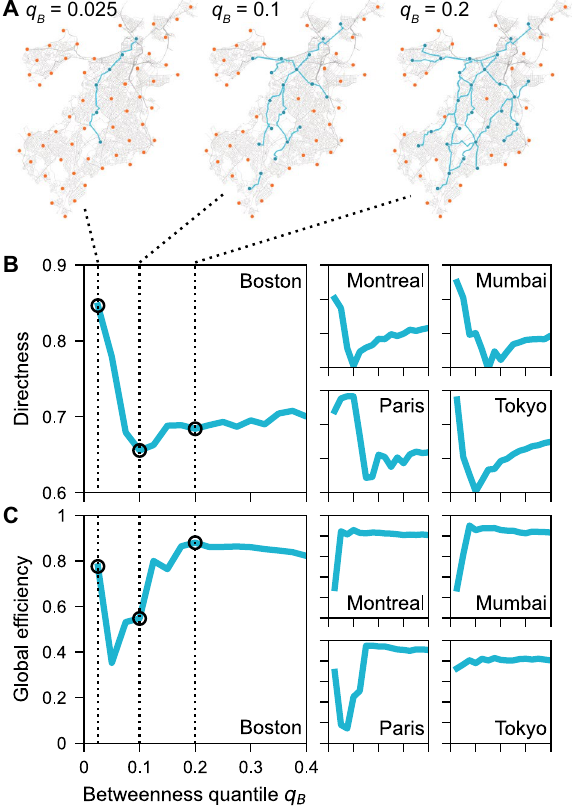
Figure 5. Network consolidation: Bicycle network growth has a dip of decreasing directness. ( A ) Three early stages of betweenness growth in Boston. ( B ) Directness sharply decreases initially due to tree-like growth (compare q B = 0.025 and q B = 0.1 for Boston). Once directness has reached a minimum ( q B = 0.1 ), it starts growing slowly due to the appearance of cycles ( q B = 0.2 ). The process is similar for the other cities (shown here for Montreal, Mumbai, Paris, Tokyo) and also holds for random growth, see Supplementary Figs. 5, 7, 8, 10. ( C ) We find mixed results for global efficiency: Mumbai and Montreal display a single jump, Tokyo is flat, while Boston and Paris shown an initial dip before increasing. Maps created with: https:// github. com/ mszell/ biken wgrow th